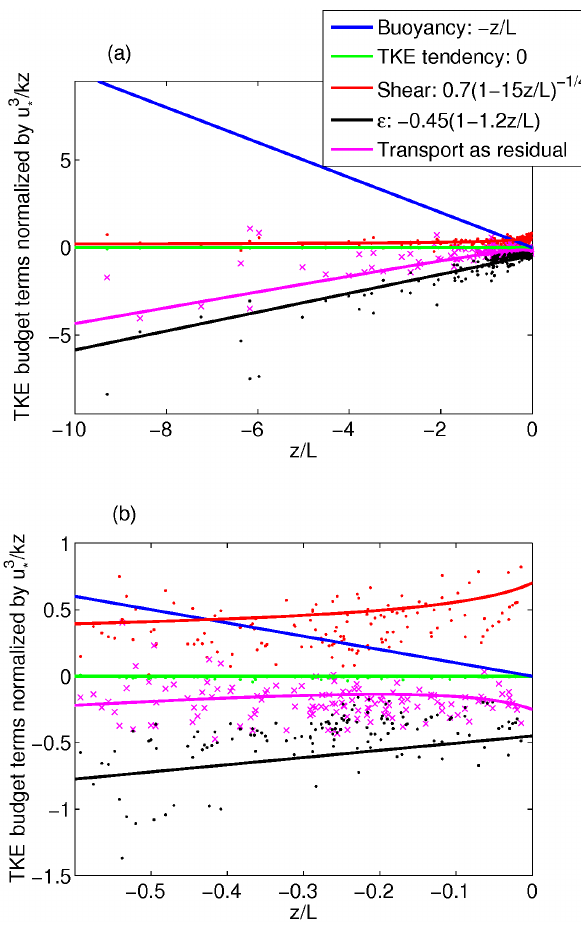
Figure 8. Normalized hourly TKE budget terms for the 10 af- ternoons shown as a function of the stability parameter z/L in panel (a) . A range of − 10 to 0 is used on the x axis, and in panel (b) the near-surface data within range of − 0.6 to 0 are shown. Data are shown with colored dots and suggested fitted expressions is shown with colored lines: buoyancy production (blue), TKE ten- dency (green), shear production (red), dissipation (black) and trans- port (magenta). Two more outlier data values (not shown) were placed at z/L = − 48 . 2 ( − 37.7) with normalized shear production = 0 . 24, (0.21), transport = − 26 . 3 ( − 20.8), dissipation = − 22 . 1 ( − 17.0) and tendency = 0 . 10